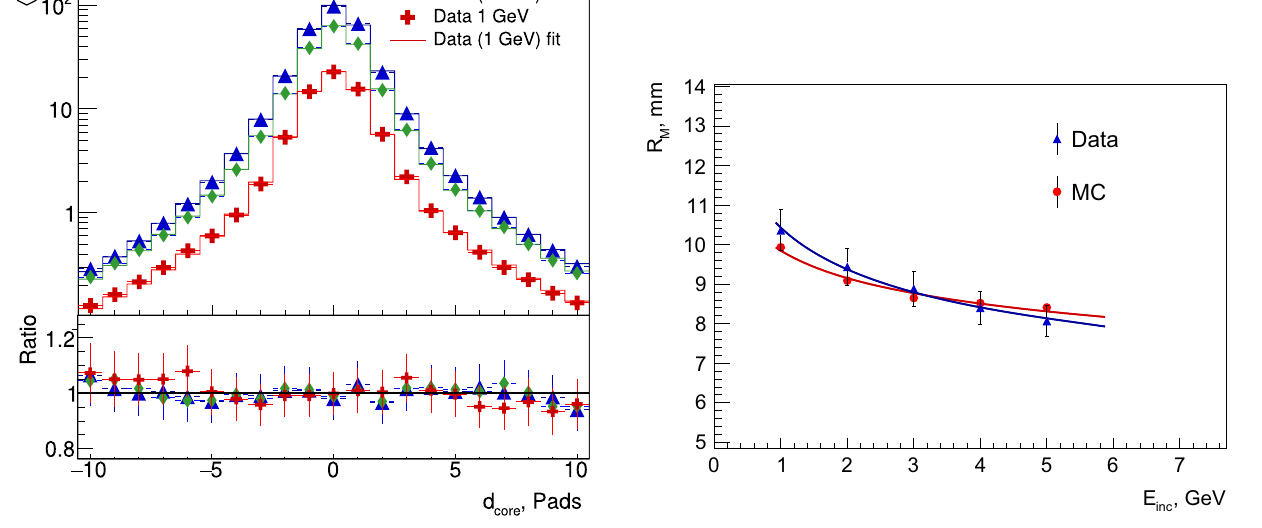
Fig. 24 The effective Molière radius as a function of the electron energy for data (blue) and simulation